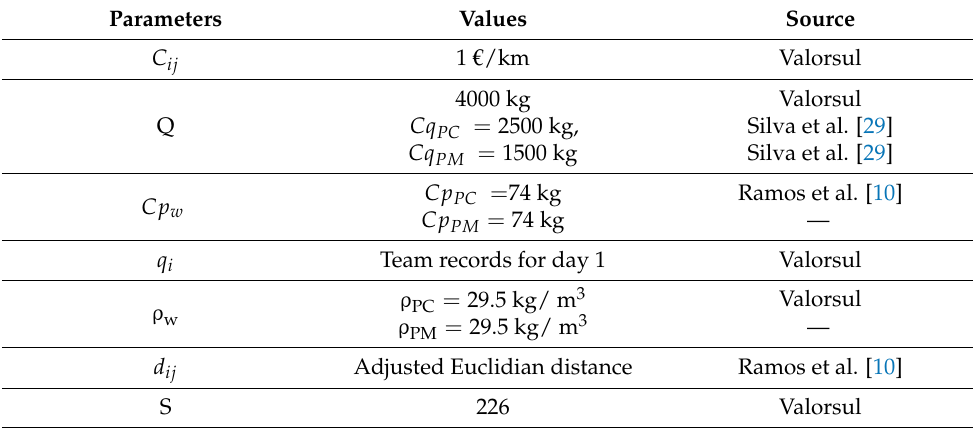
Table 7. Parameters values and sources.